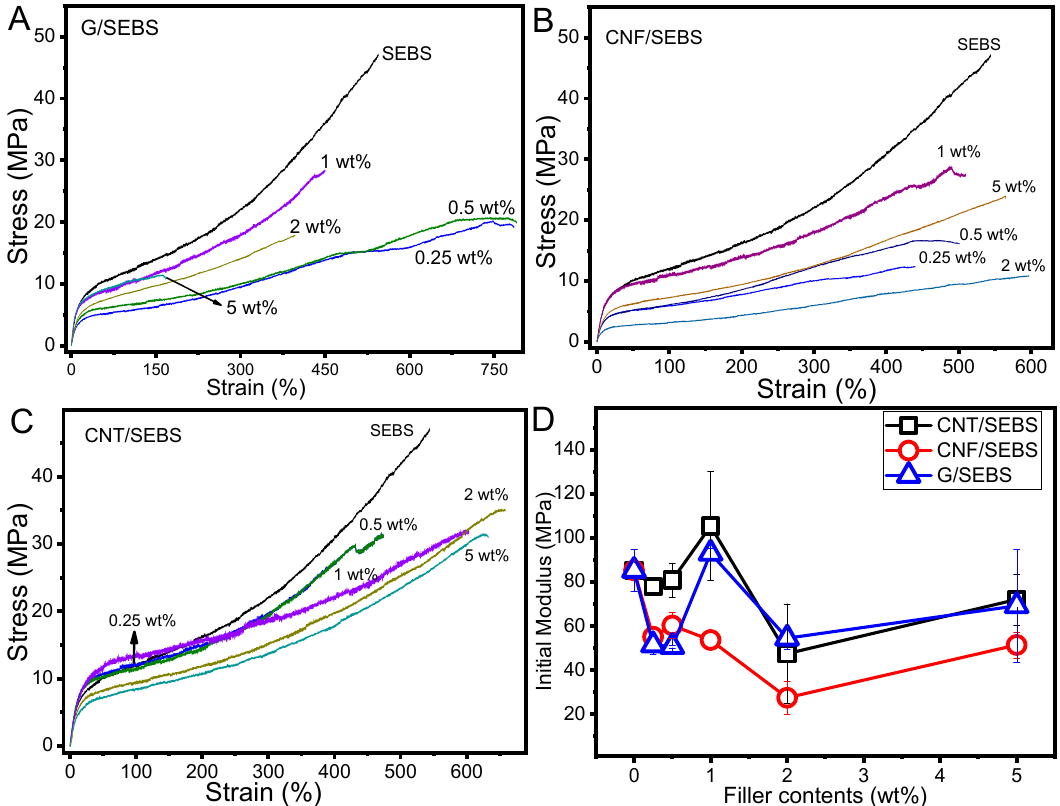
Figure 5. Mechanical properties of SEBS and its nanocomposites reinforced with ( A ) CNF; ( B ) CNT; and ( C ) graphene up to 5 wt.%. ( D ) The initial modulus of the materials as a function of nanofiller content.